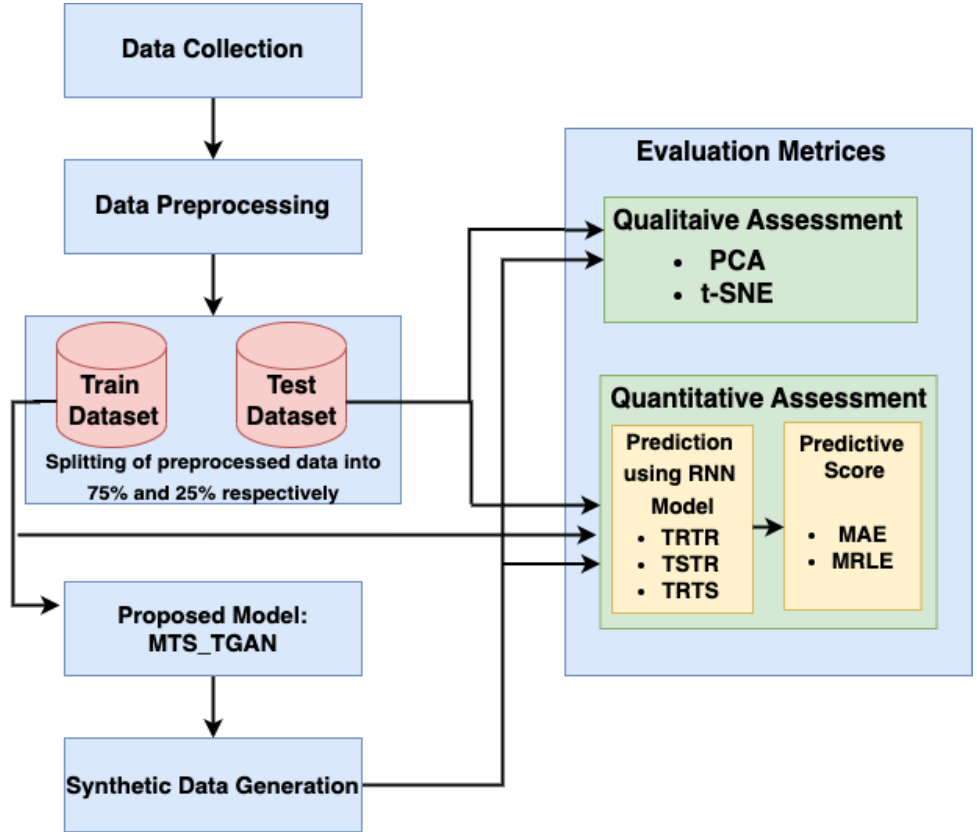
Figure 3. Process flow of the proposed